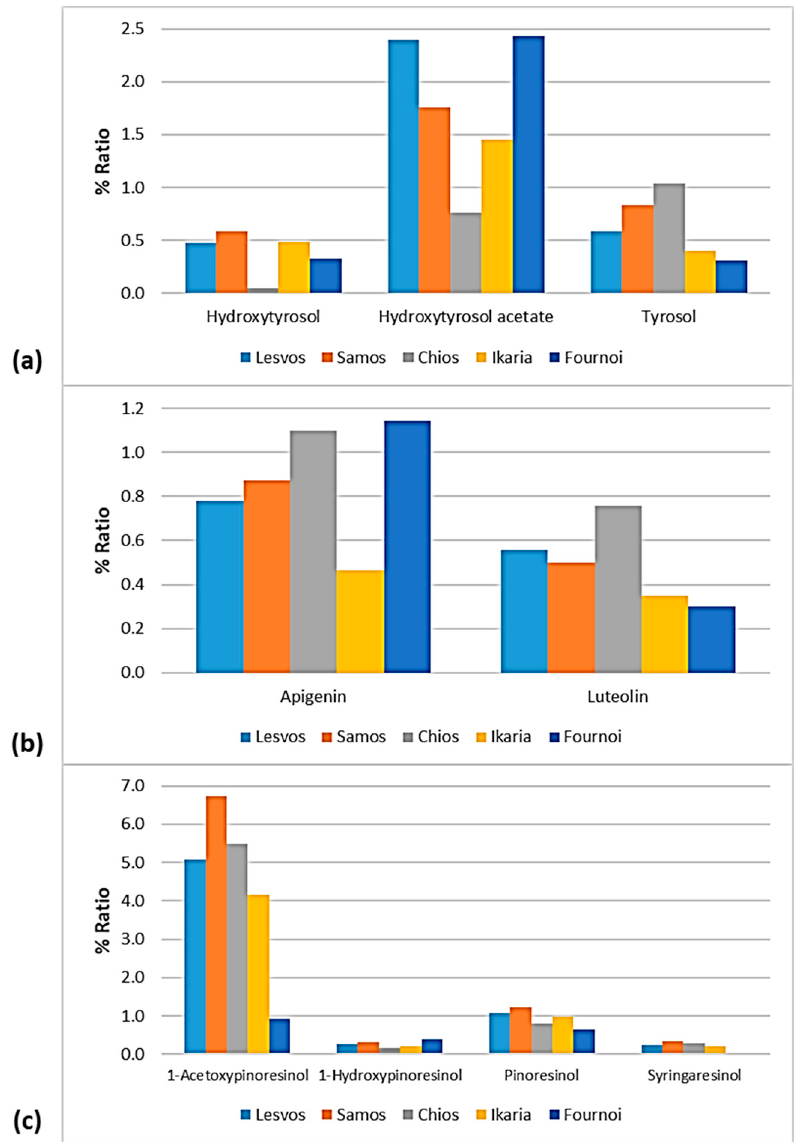
Figure 12. % Ratio of the compounds from the class of ( a ) phenolic alcohols (hydroxytyrosol, hydroxytyrosol acetate, and tyrosol), ( b ) flavonoids (apigenin and luteolin), and ( c ) lignans (1-acetoxypinoresinol, 1-hydroxypinoresinol, pinoresinol, and syringaresinol) to the phenolic con- tent in the EVOOs between the islands (Lesvos, Samos, Chios, Ikaria, and Fournoi) of the North Aegean